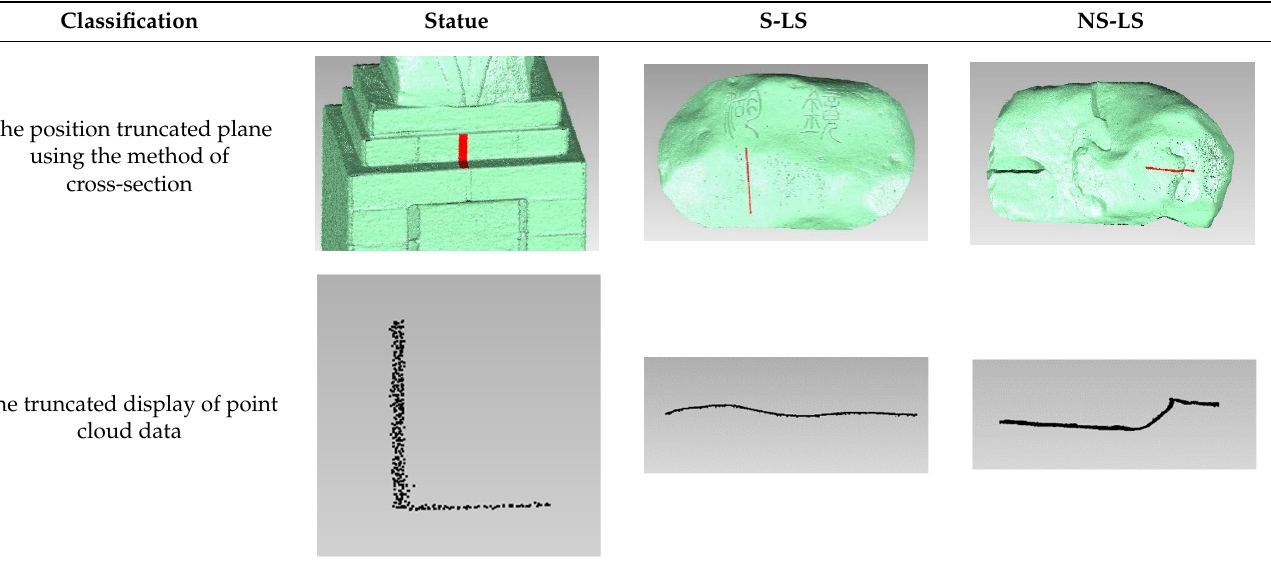
Table 4. The truncated point cloud data by the method of cross-section.